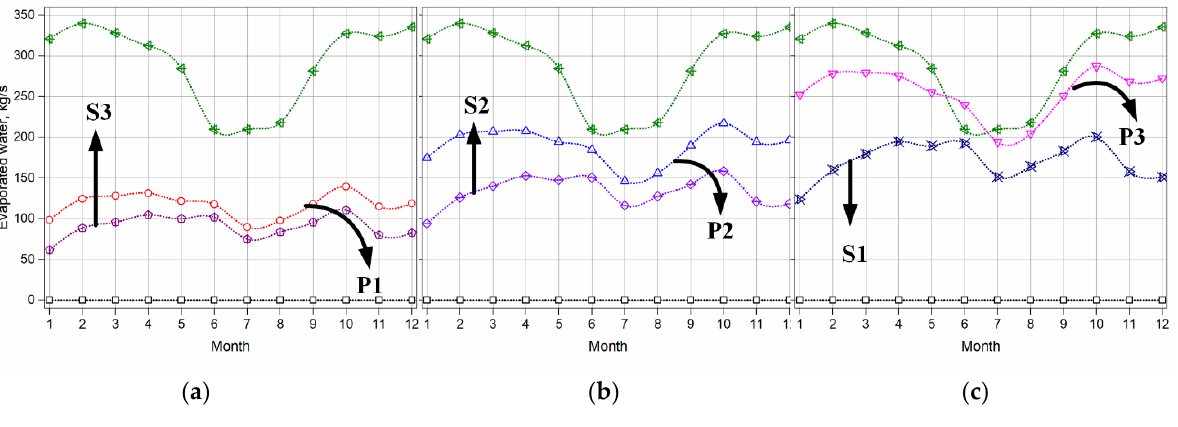
Figure 8. Water loss comparisons ( a ) S3-P1 ( b ) S2-P2 ( c ) S1-P3.